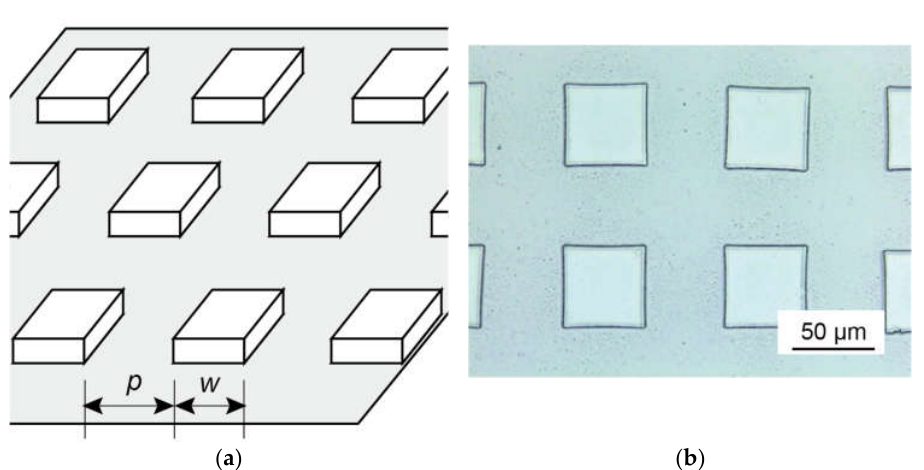
Figure 3. Tactile samples with square pattern for dry perception experiment: ( a ) diagram of pattern, where w is the square width and p is the gap between squares; ( b ) microscopy image of